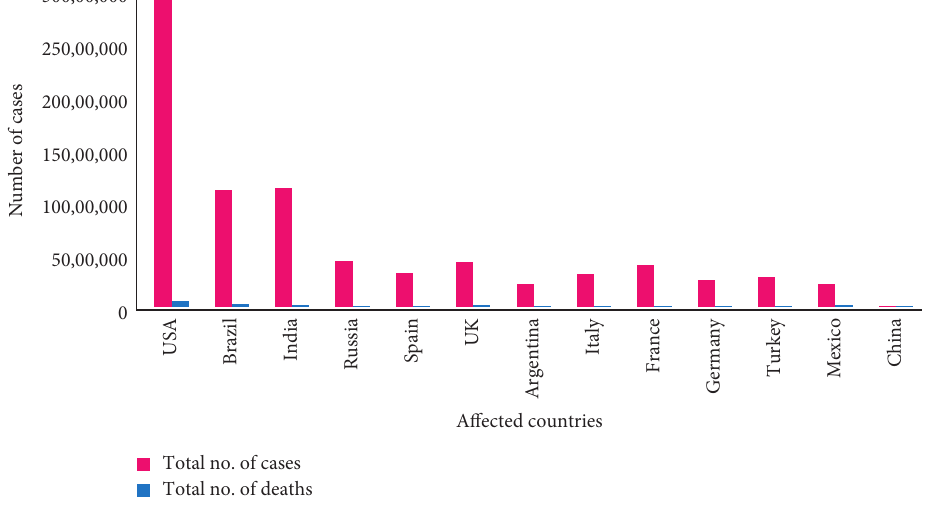
Figure 1: The most affected countries with COVID-19 in the world [7].